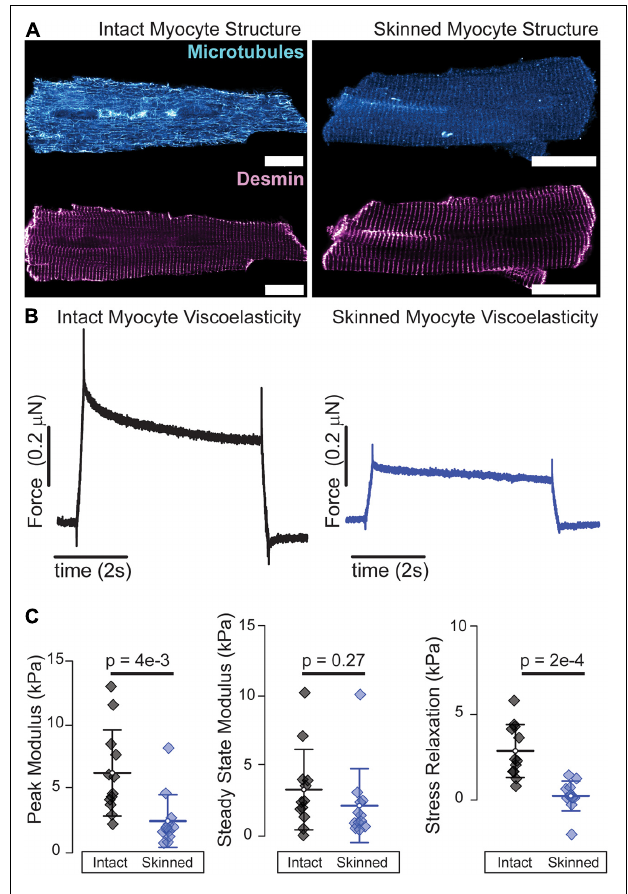
FIGURE 2 | Skinned cardiomyocytes exhibit a loss of microtubules and reduced viscoelasticity. (A) Representative fluorescence images of microtubules and desmin intermediate filaments in an intact (left) and skinned (0.1% Triton X-100 30 min at room temperature) (right) cardiomyocyte. (B) Average viscoelasticity of intact cardiomyocytes (left) and skinned cardiomyocytes (right). (C) Average data for peak, steady-state and stress relaxation, mean line with SD whiskers; p -values determined from paired-sample t -test. N = 12 rates and n = 12 myocytes for each. Viscoelastic test is a 15% length step in 200 ms. Scale bar = 20 µ